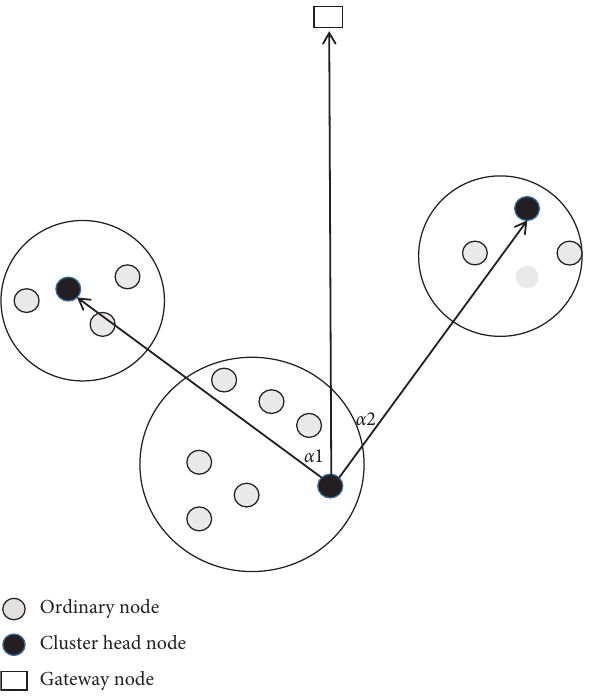
Figure 3: Routing and angle diagram among